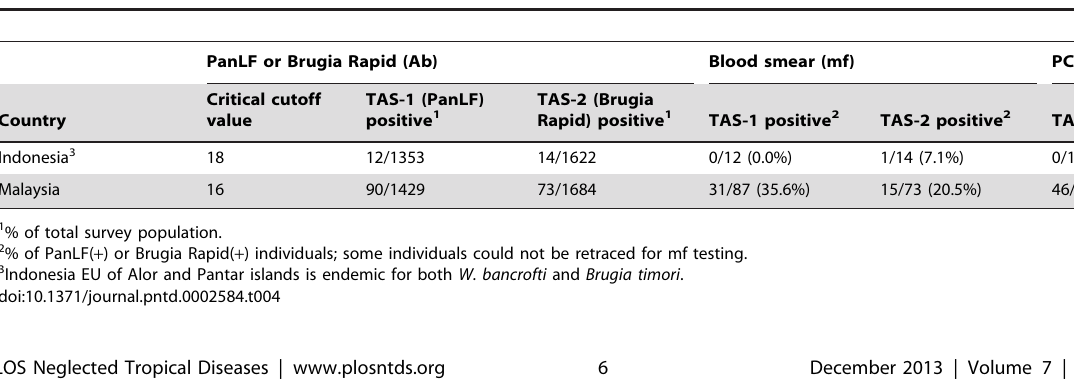
Table 4. PanLF, Brugia Rapid, blood smear, and PCR results for Brugia spp.